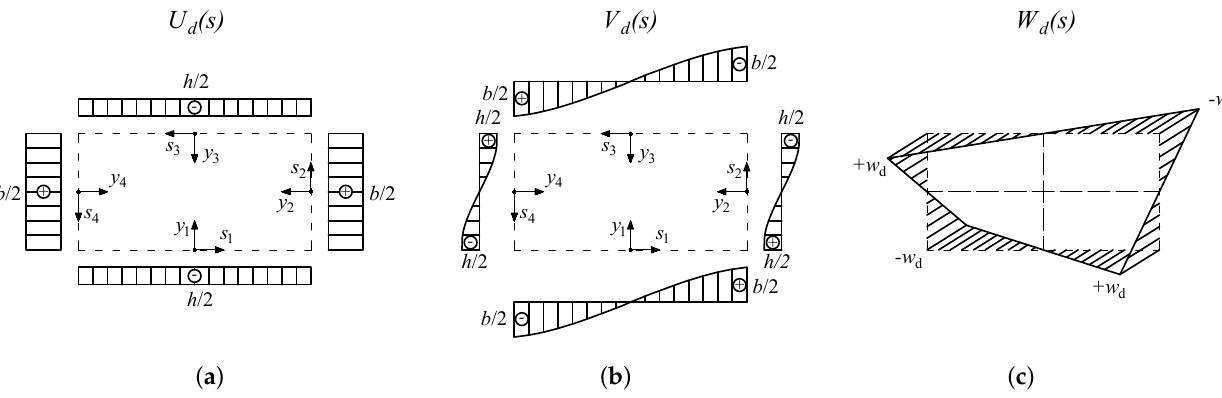
for different thickness ratios t 1 h